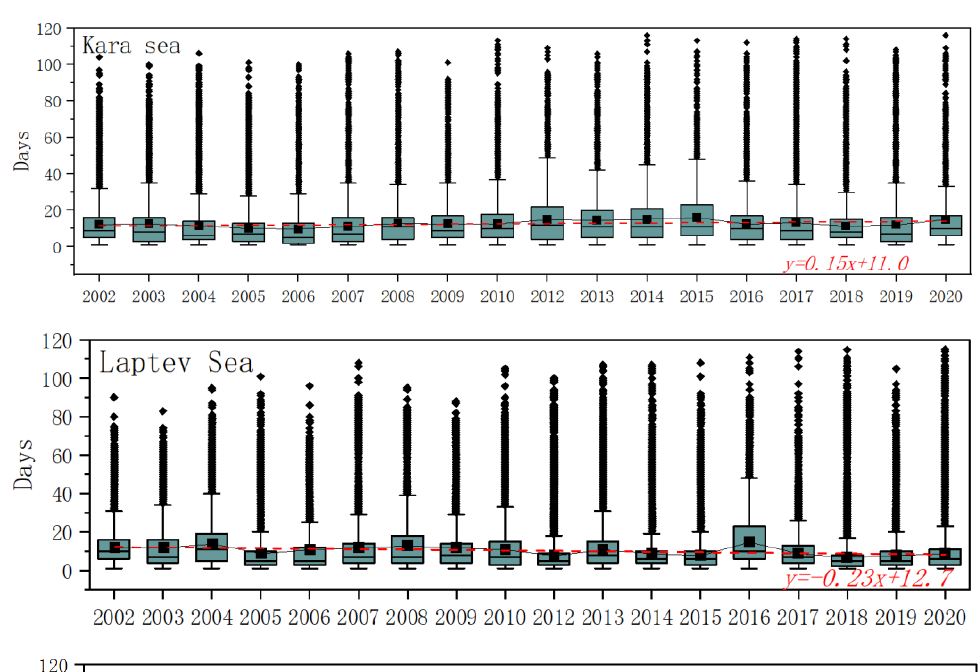
Figure 14. Number of days from freezing up to complete freezing of Arctic sea ice, 2002 – 2020.